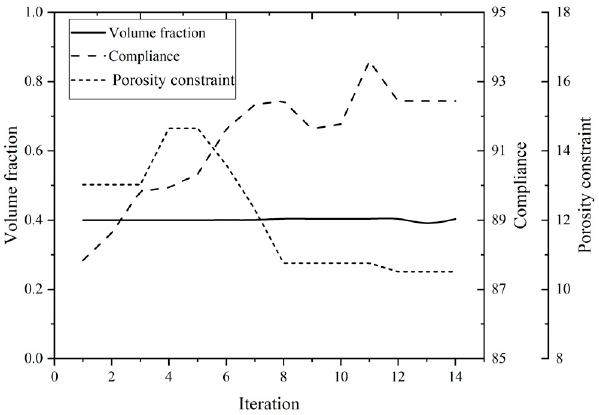
Figure 5. Convergence history of L-shaped beam by hole nucleation method.